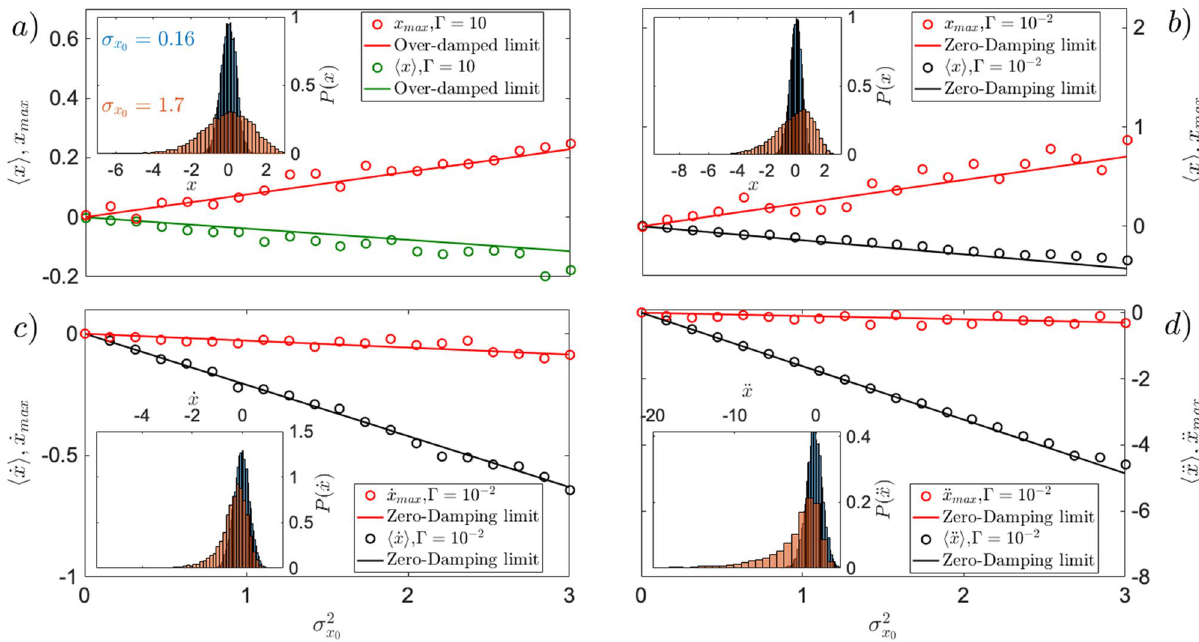
Figure 5. Initial uncertainty-induced shift of maximum of position x max , for high (a) and low (b) pressure x max (c) , and acceleration x max (d) . All simulations (dots) have been limit, maximum of instantaneous velocity ˙ ¨ x 0 x 0 1 . The top panel highlights the atypical evolution 0 , and σ 2 performed based on Eq. (1) using x 0 = � � = �˙ � = ˙ of maximum of particle position x max ( a , red dots) retrieved in 27,30 for over-damped dynamics ( a , red line), and witnessed again in the low pressure limit ( b , red). To make the shift in maximum more visible, Eq. (1) has x max , in the low pressure limit (c) , 0.3 ms. The maximum of instantaneous velocity been simulated with t ˙ = x max (red) alongside the potential force (black) The introduces a new effect comprising of a coherent shift of ˙ x at different σ 2 inset, showing snapshots of the P ( x 0 , highlights the instability (heavy tails on the left), with a ˙ x max ( d , red), shifts clear shift of the maximum alongside. Similarly, the maximum of instantaneous acceleration ¨ x x max for different coherently with its mean (black), corroborated by the inset picture, showing the left shift of ¨ �¨ � x max , and x max , we notice that the latter is comprised of a larger shift values of σ 2 x . By comparing the shift of 0 ˙ ¨ x ) , and P ( x ) (inset a,b ), with the P ( x ) induced by initial position uncertainty σ 2 x . Moreover, comparing the P ( 0 ˙ ¨ (inset c,d ), we notice the absence of light tail in the former, that is visible in position 27 . To produce the figure on 0.1 ms. The other parameters used to produce this graph the bottom panel, Eq. (1) has been simulated with t = 6 k B T µ m − 3 kg − 1 , T = 300 K , dt 10 4 trajectories where generated with 2 10 − 5 ms. N t from Eq. (1) are κ = = = × N 5000 samples =